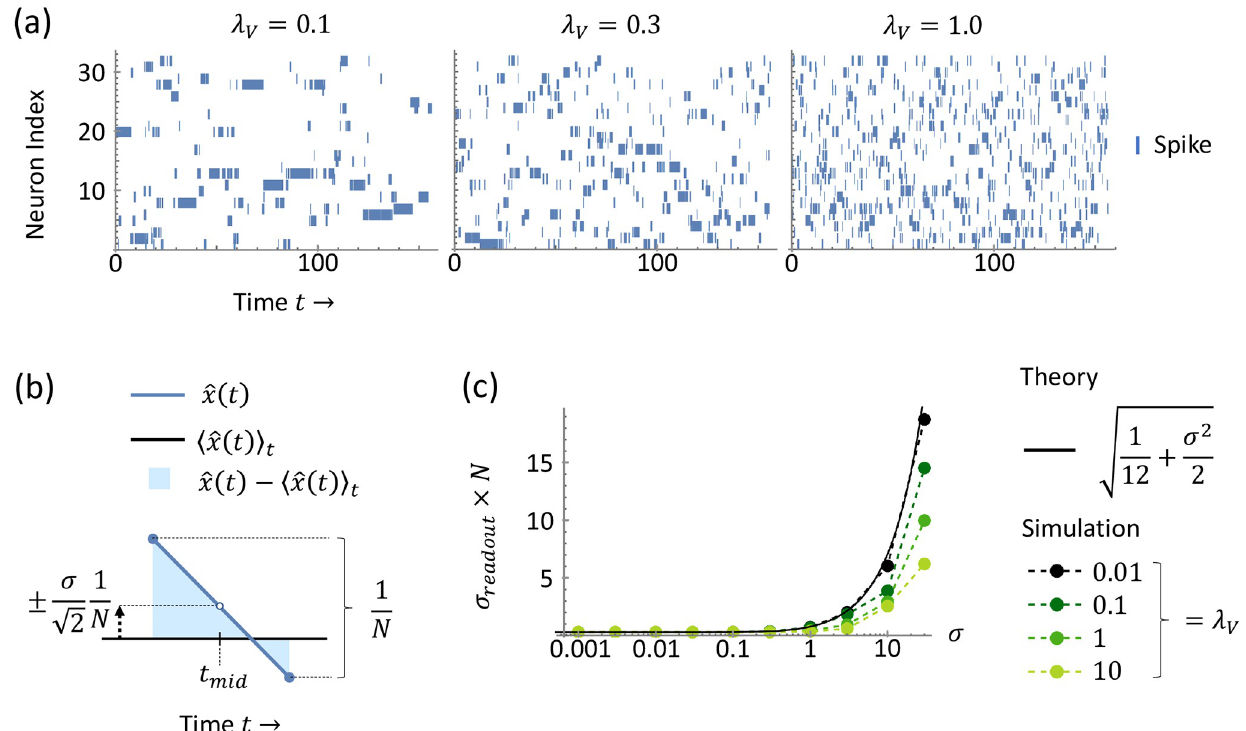
Fig 3. LIF model with zero delay. (a) Spike raster plots from simulations ( N = 32) for three different values of the membrane potential leak λ small λ V , we observe long runs in which the same neuron repeatedly spikes. Thus in the small λ V limit, the next spike time is well-approximated by considering only the possibility that the same neuron spikes again. (b) Readout ^ x ð t Þ (blue) and its deviation ^ x ð t Þ (cid:0) x ð t Þ (light blue shaded) from the mean h ^ x ð t Þi for a single interspike interval. The variations in interspike interval durations accumulate to produce a variation in the readout with standard t deviation s ffiffi , using the approximation from (a). (c) Readout error σ p 1 2 N illustrated in (b) across time yields the readout error in the small λ upper-bounded by Eq